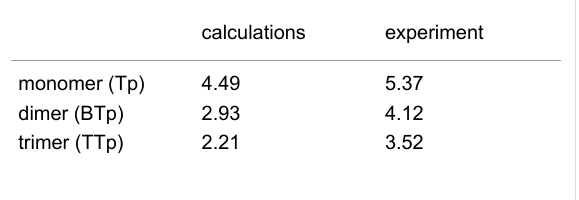
structure can be improved by including self-energy corrections.